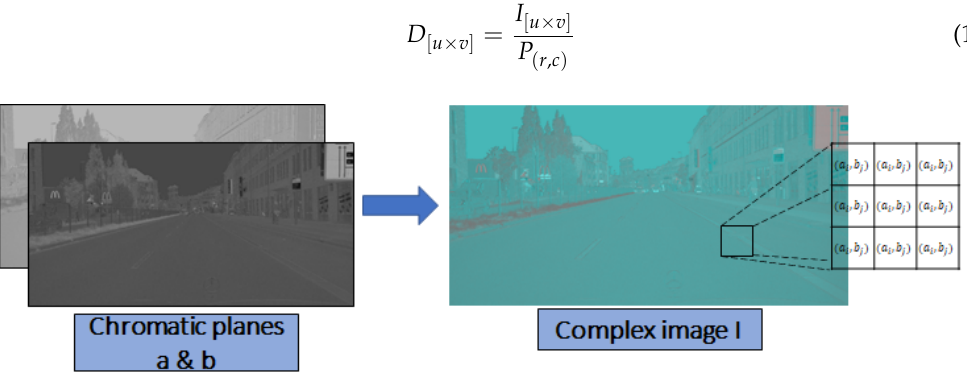
Figure 2. Generating complex image I using the chromatic images imA and imB